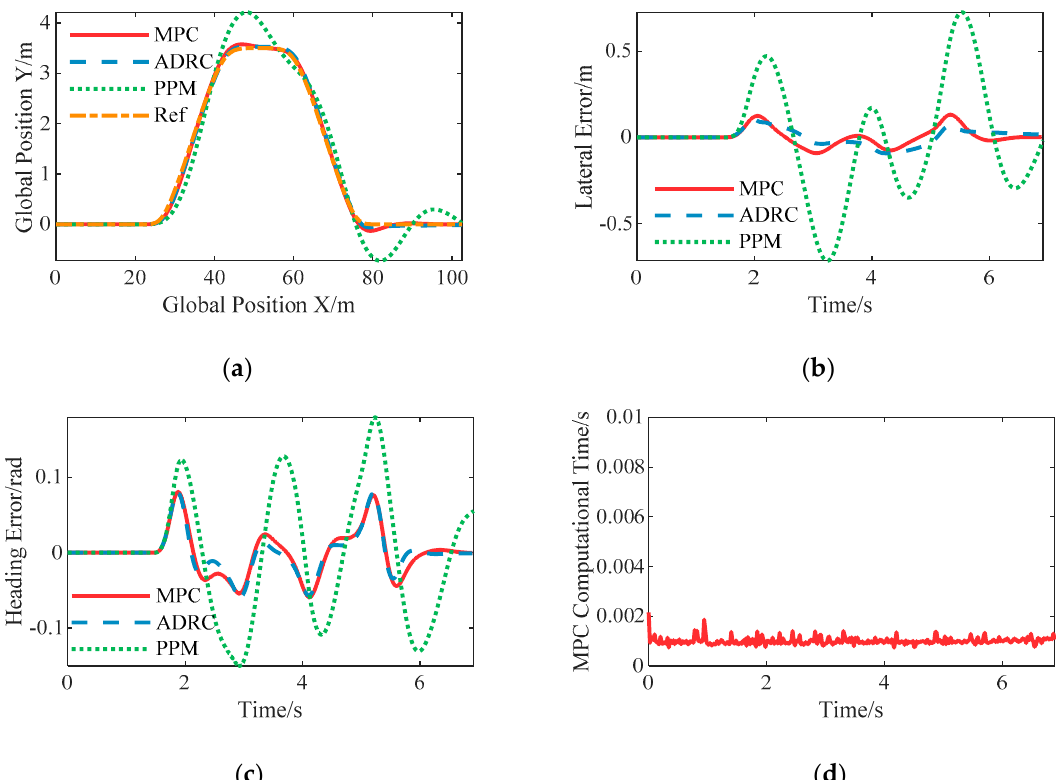
Figure 11. Simulation results of double lane change with constant speed 15 m / s: ( a ) The spatial path of the vehicle following the given path; ( b ) The resulting lateral error; ( c ) The resulting heading angle error; ( d ) The computational time of the proposed LPV-MPC controller.